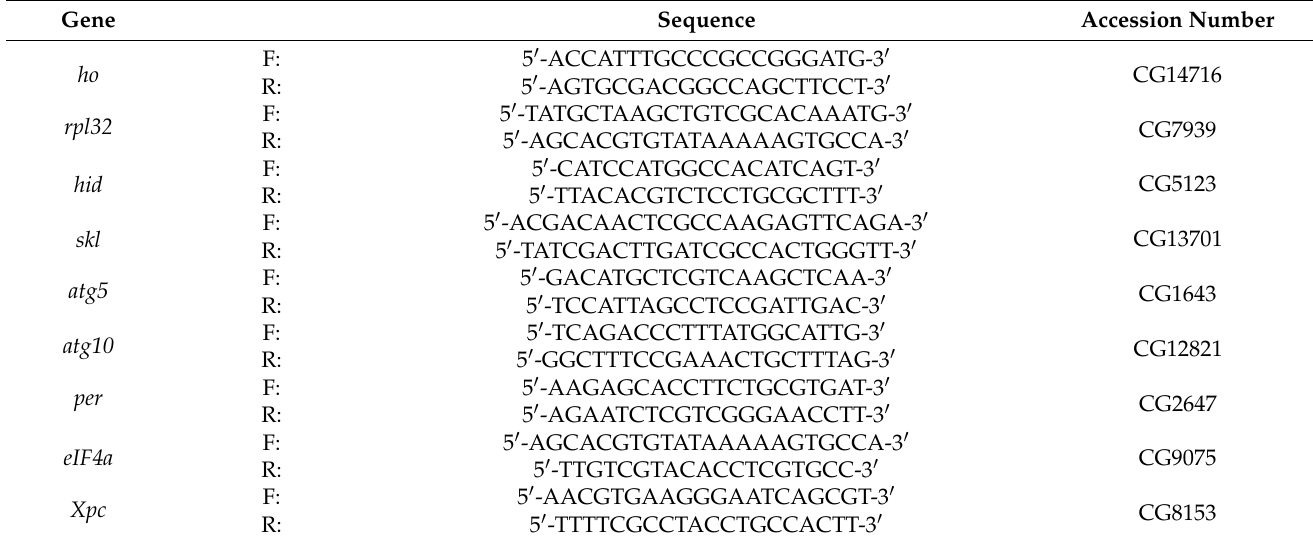
Table 1. Primer sequences of the genes which were used in this